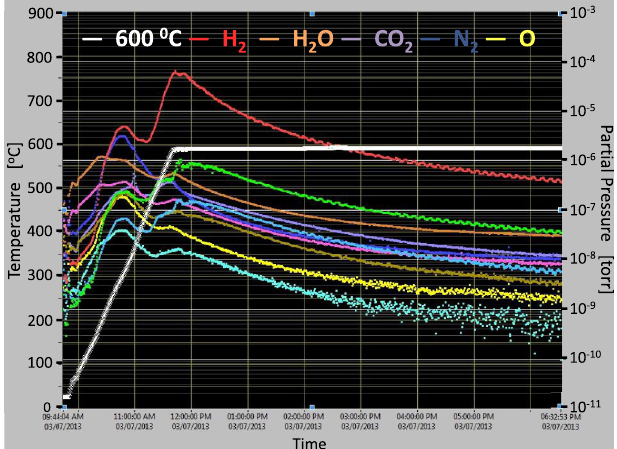
FIG. 7. Furnace temperature and H 2 partial pressure level during high-vacuum heat treatment.